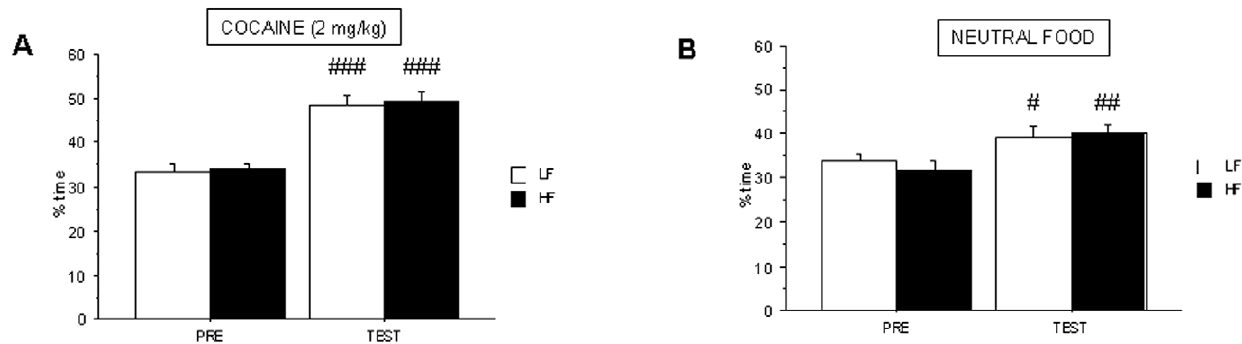
Figure 5. Forced synchronized diet in cocaine 2 mg/kg CPP and food CPP. CPP was induced after re-organization of feeding behavior in control and HF groups. Animals were tested during 30 min and results are expressed as % time spent in the white food (A)or cocaine-paired (B) arm. Values are mean 6 S.E.M. of 15–16 animals # p , 0.05, ## p , 0.01, ### p , 0.001 for comparison between testing –TEST- and preconditioning –PRE-